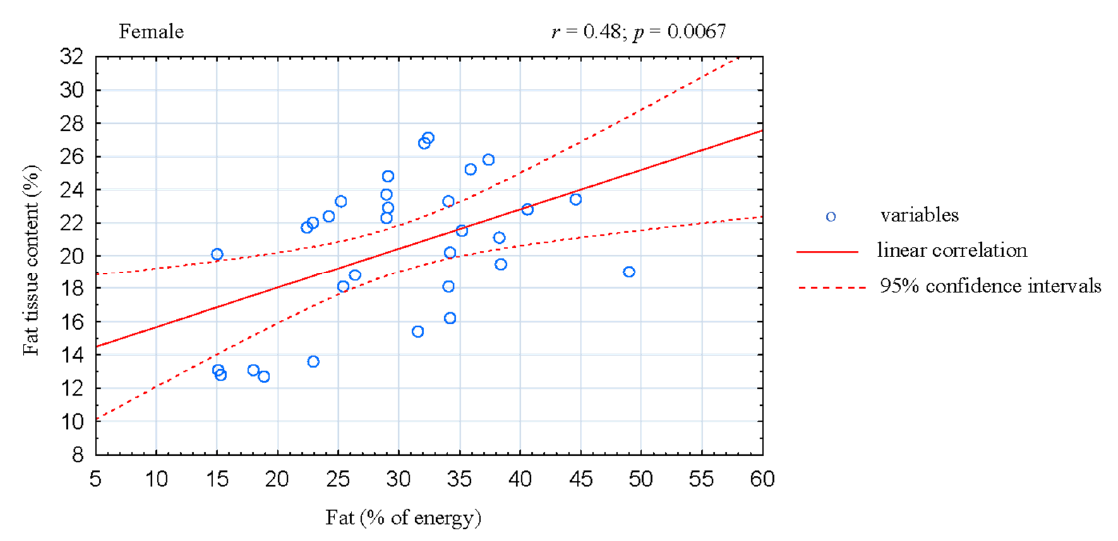
Figure 3. Correlation between dietary fat intake and fat tissue content in female CrossFit-trained individuals.